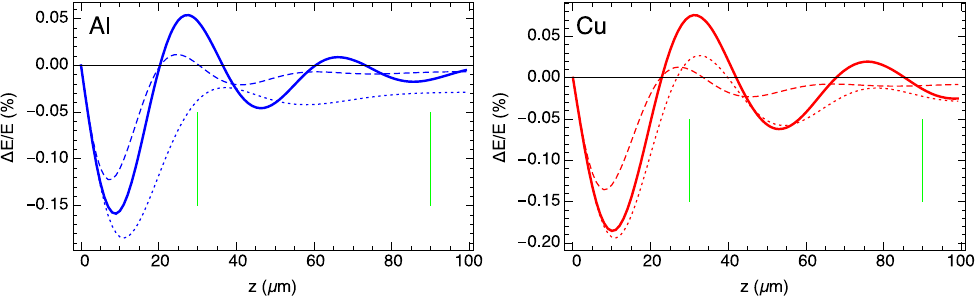
5. For flat geometry: the relative energy change of electrons in a beam with flat distribution in aluminum chamber (left panel, solid line) and copper chamber (right panel, solid line). For comparison, we show by dashed lines (with the same correspondence between the color and the wall material) obtained for the energy change when one uses the EASE model of Ref. [3]. The dotted lines show the relative energy change for the case when the pipe is at room temperature. The vertical green lines indicate the rear edge of the bunch distribution: 30 μ m for 100 pC and 90 μ m for 300 pC.